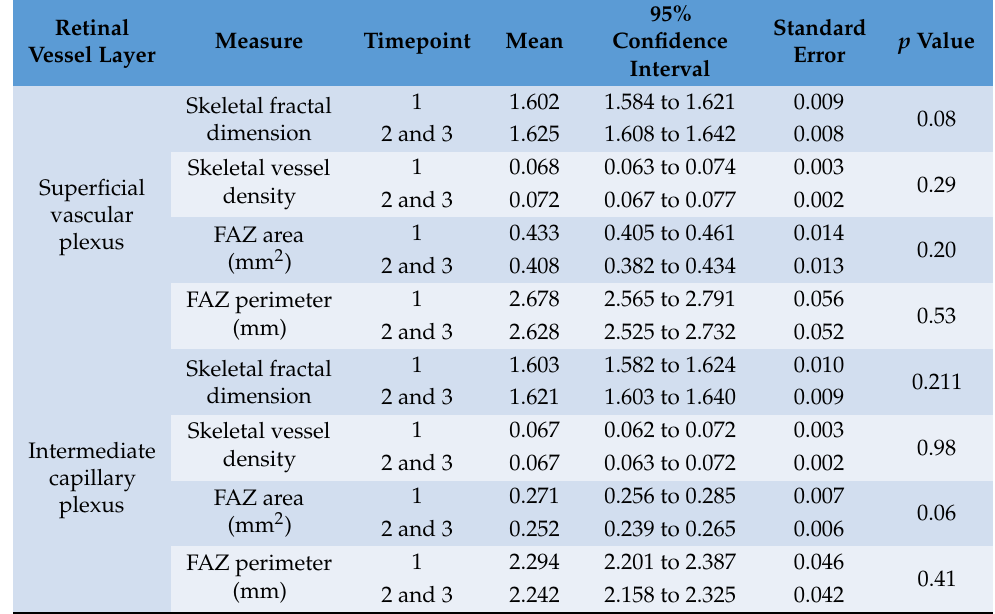
Table 1. Mean patient difference values between timepoints in each blood flow measure of the superficial vascular plexus and intermediate capillary plexus. Timepoints: 1, pre-op; 2 and 3, 24–48 h and 7 days post-op; FAZ: foveal avascular zone.